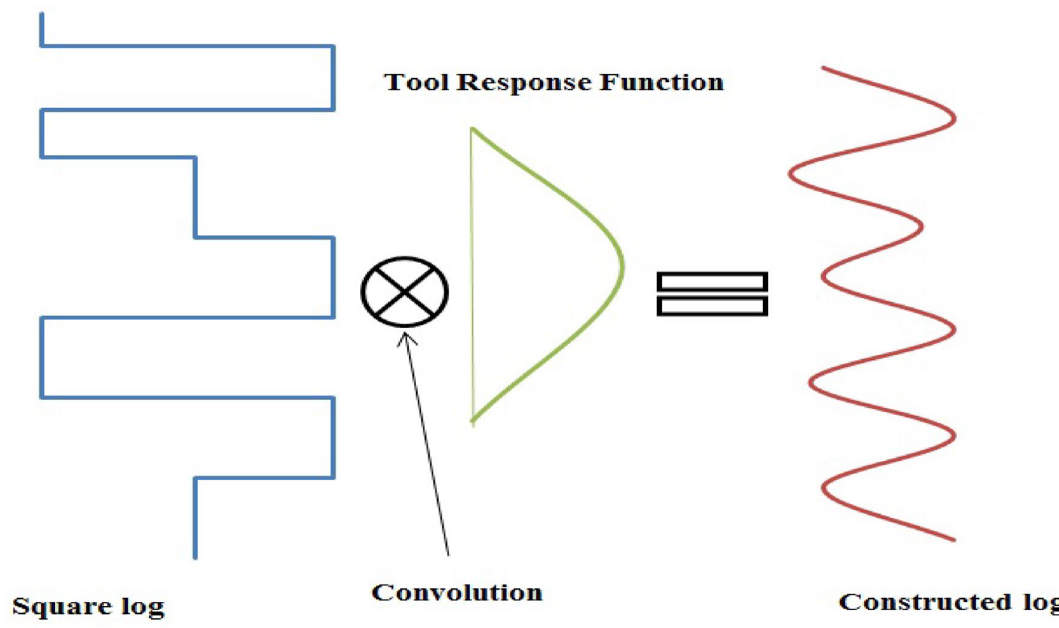
Fig. 8 Obtaining the constructed log from square log